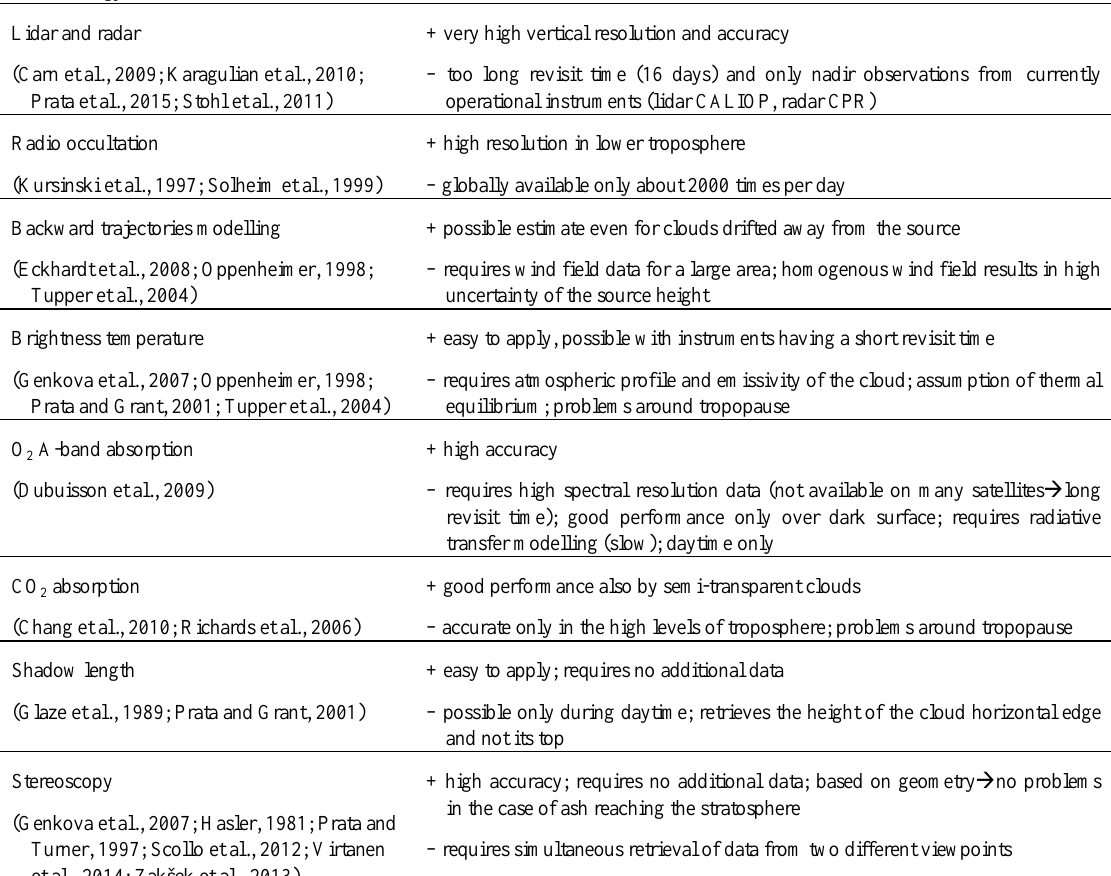
Table 1. Comparisons of satellite methods for aerosol / meteorological cloud top height